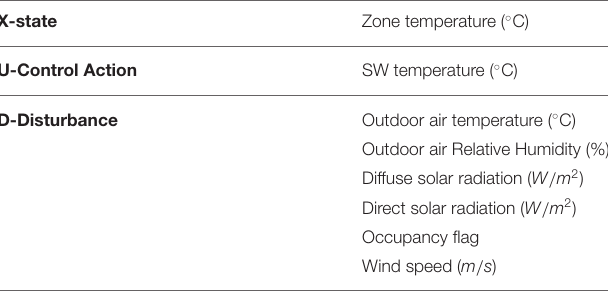
TABLE 2 | The state, action, and disturbance terms defined for the simulation study on Intelligent Workspace, a 600 m 2 multi-functional space. X-state